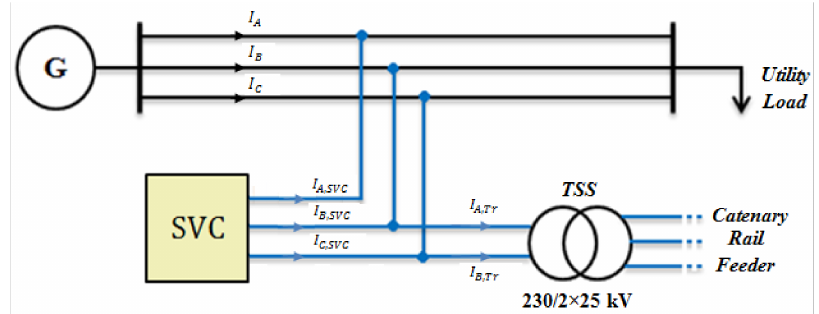
Figure 6. SVC location in the